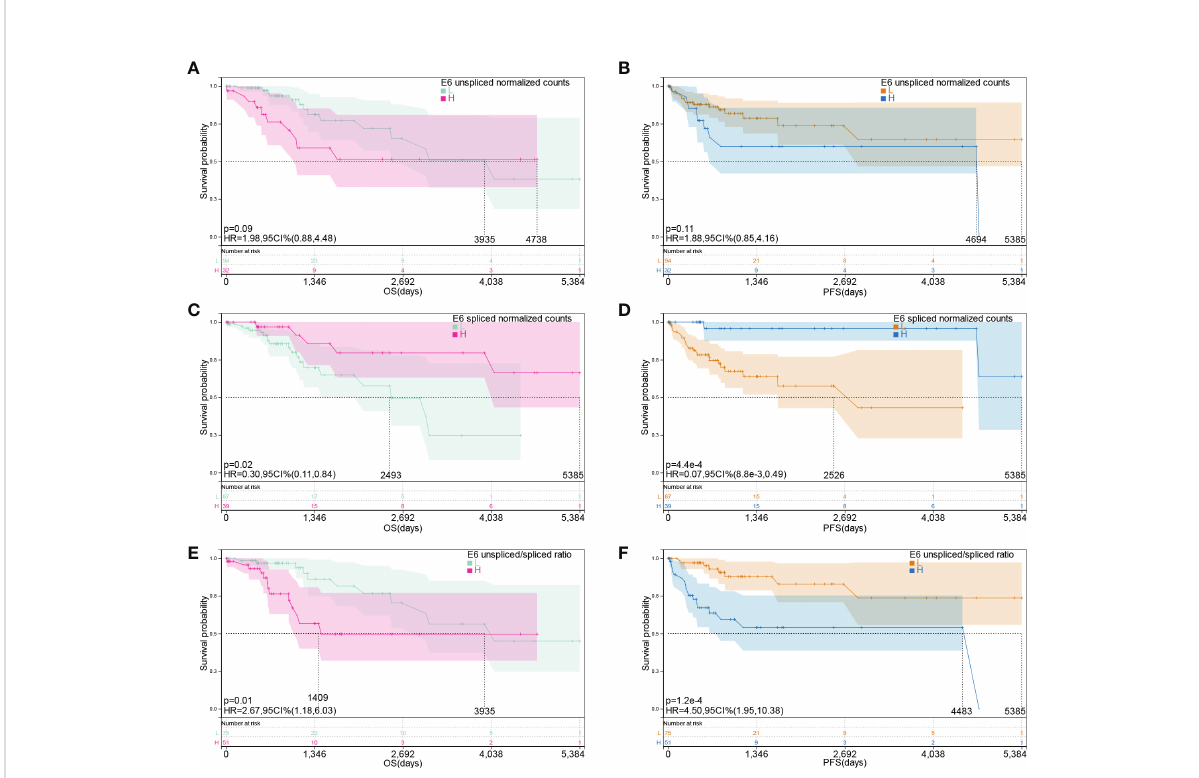
FIGURE 2 E6 splicing is associated with survival outcome in cervical cancer. (A, B) Overall survival and disease-free survival of E6 unspliced normalized counts (E6) in TCGA- CESC cohort. (C, D) Overall survival and disease-free survival of E6 spliced normalized counts (E6*) in TCGA-CESC cohort. (E, F) Overall survival and disease-free survival of unspliced/spliced E6 ratio (E6ratio) in TCGA-CESC